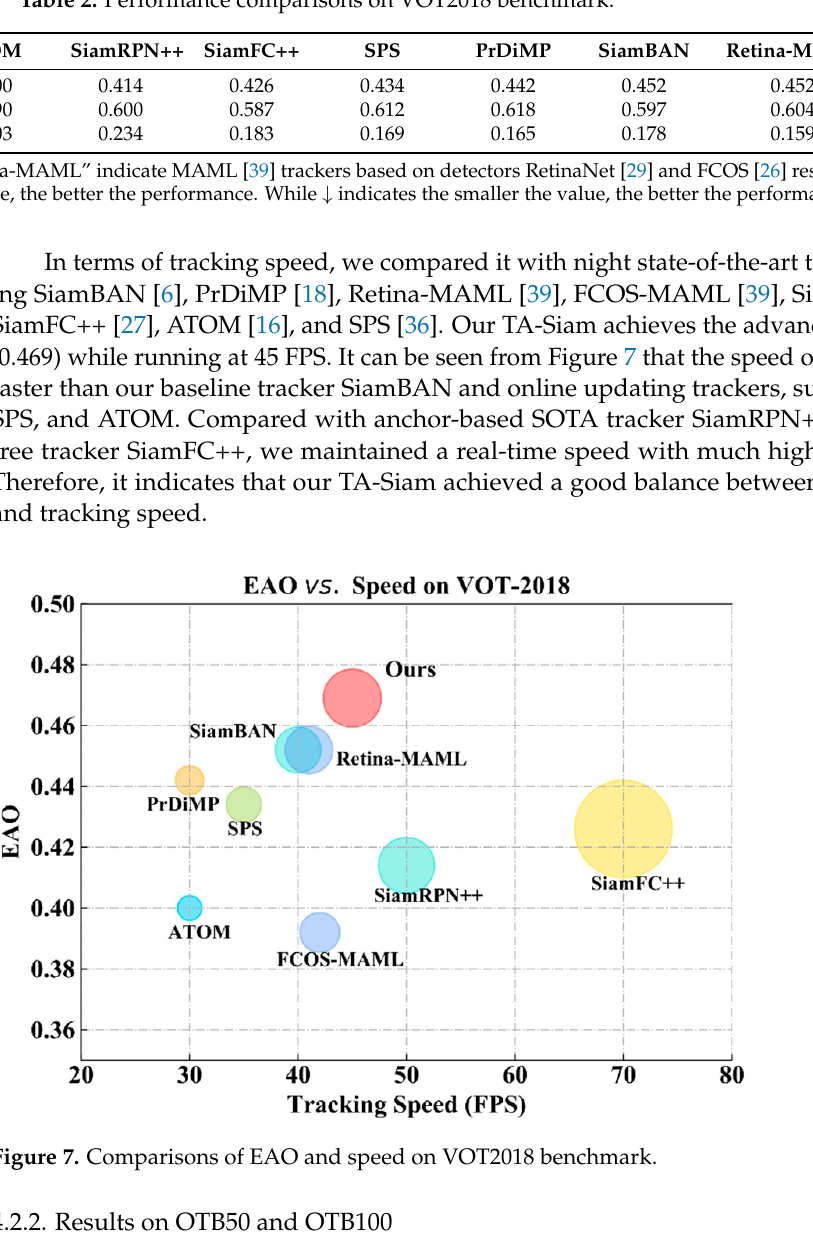
Figure 8. The precision plots and success plots on OTB50 dataset.